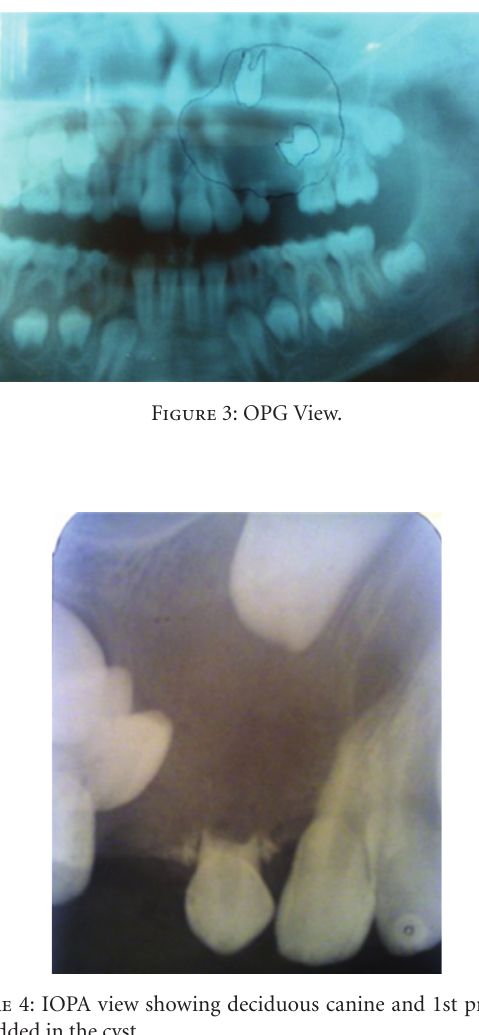
Figure 4: IOPA view showing deciduous canine and 1st premolar embedded in the cyst.